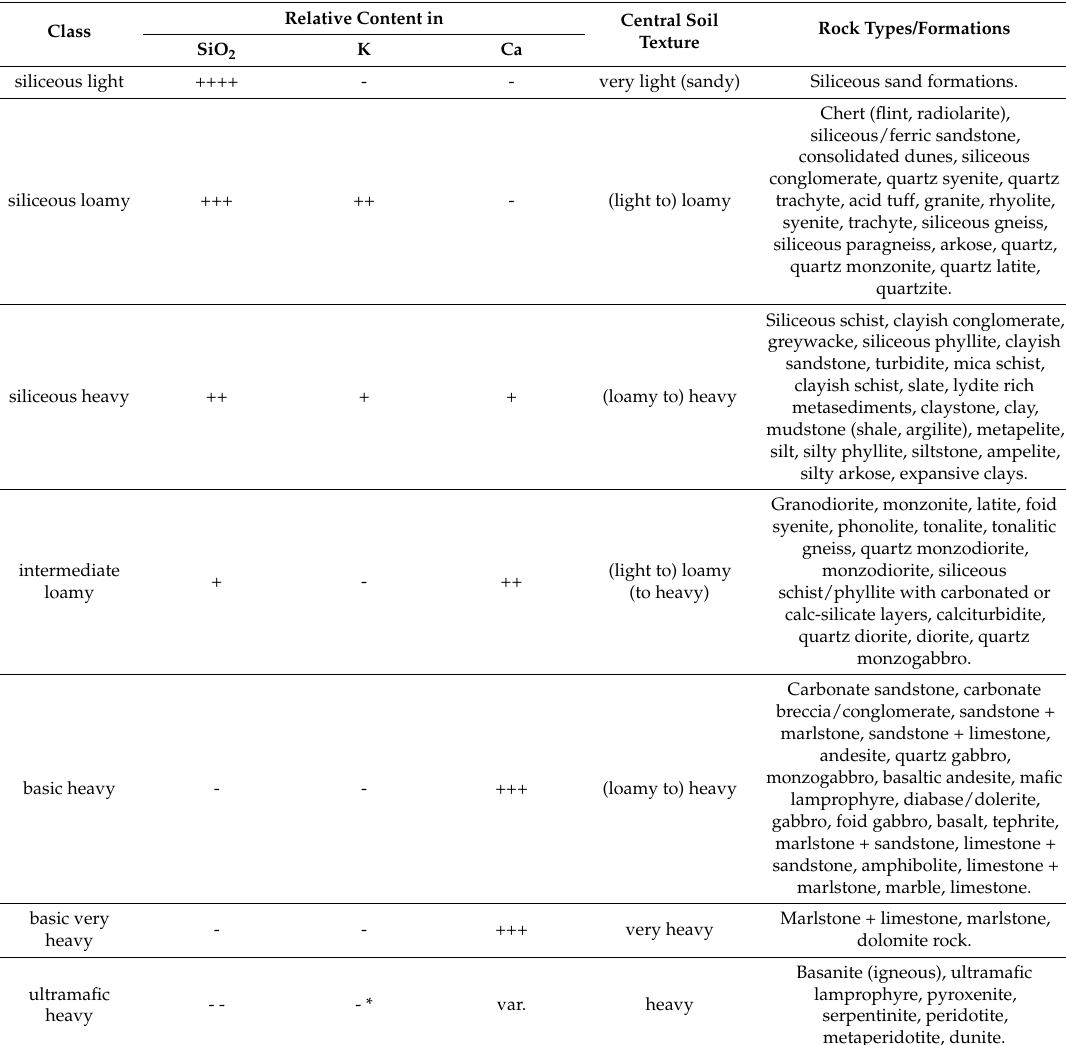
Table A2. Detailed characterization of the defined classes: relative content of SiO 2 , K and Ca, central (potential) soil texture and included rock